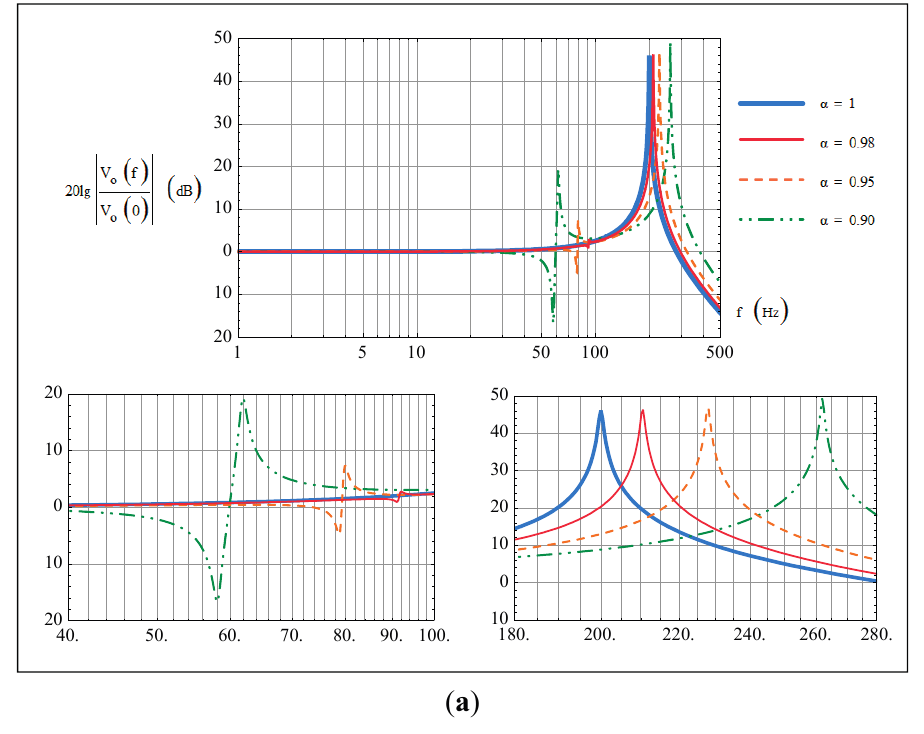
Figure 5. ( a ) Input-output amplitude-frequency response with non-ideal α values; ( b ) Input-output amplitude-frequency response with non-ideal β